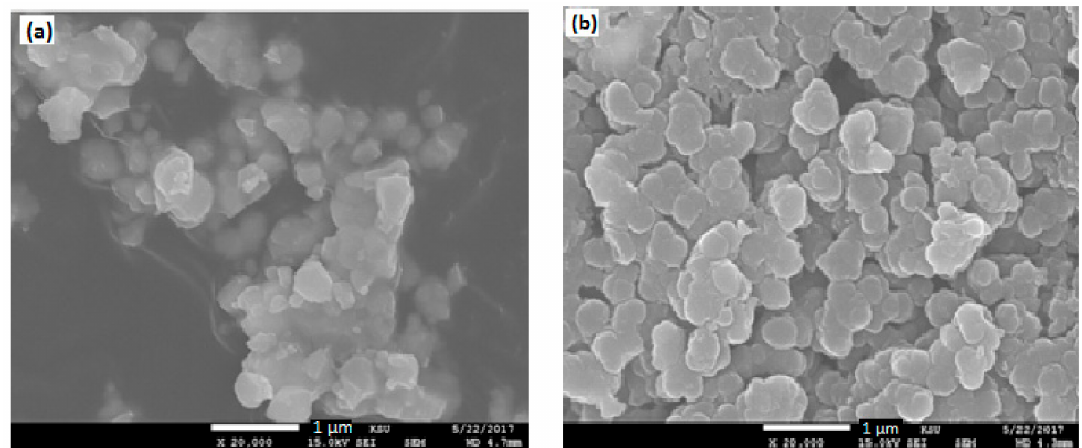
Figure 7. SEM images of ( a ) BaTiO 3 , ( b ) Pure Polypyrrole.